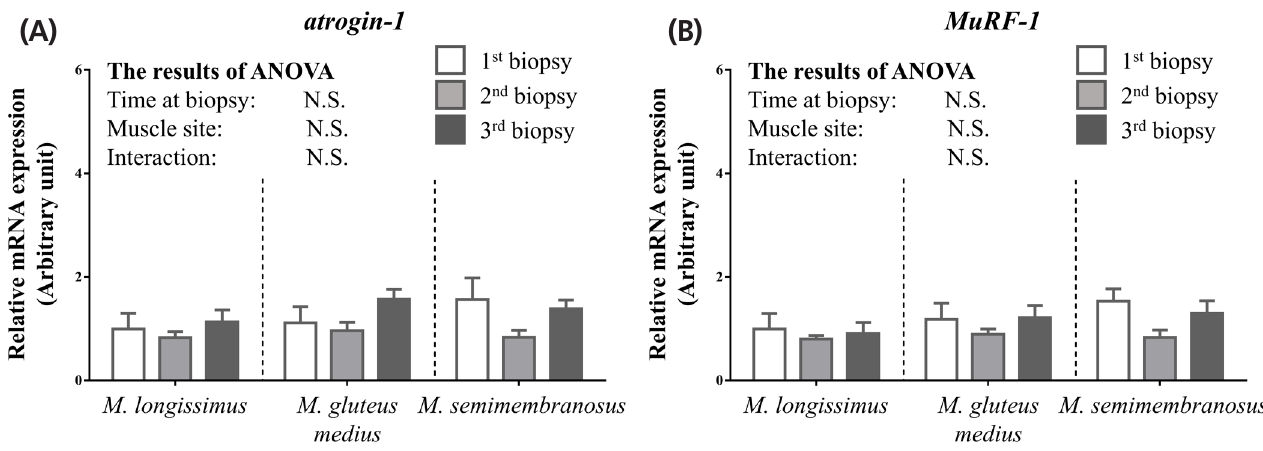
Figure 3. Effects of the fattening stage on expression of genes associated with the ubiquitin-proteasome system in M. longissimus, M. gluteus medius, and M. semimembranosus of Japanese Black cattle. After skeletal muscle biopsy, mRNA expression of atrogin-1 (A) and MuRF-1 (B) was measured by quantitative reverse- transcription polymerase chain reaction. The data (total n = 54 for each gene: six cattle×three time points×three muscle sites) are analyzed by comparing groups using a two-way analysis of variance (factor: time at biopsy and muscle site) and are expressed as means±standard error of the mean. Statistical significance was defined as p<0.05. MuRF-1, muscle RING-finger